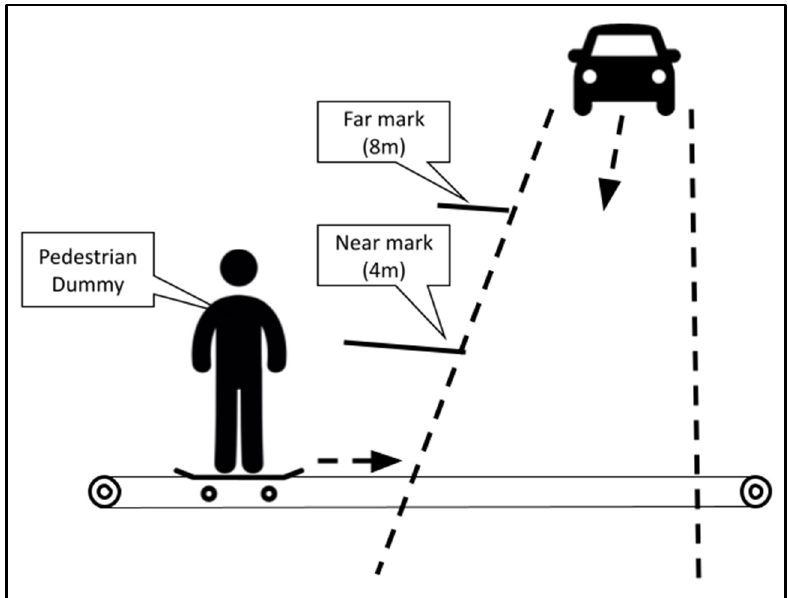
Figure 4. Pedestrian dummy crossing manipulation, consisting of a pedestrian dummy (fixed on a skateboard moved by cables) being moved into the driving route at one of two distances in front of the vehicle: 4 m (close) or 8 m (far).